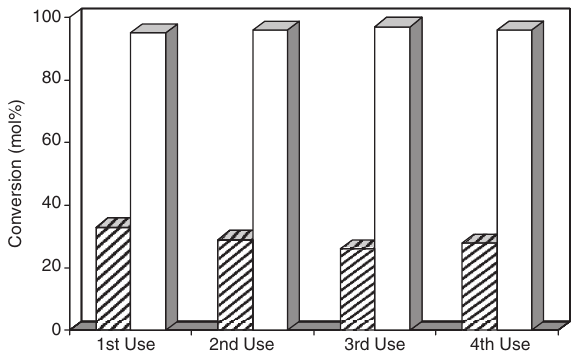
of 4-fluorobenzyl alcohol with H